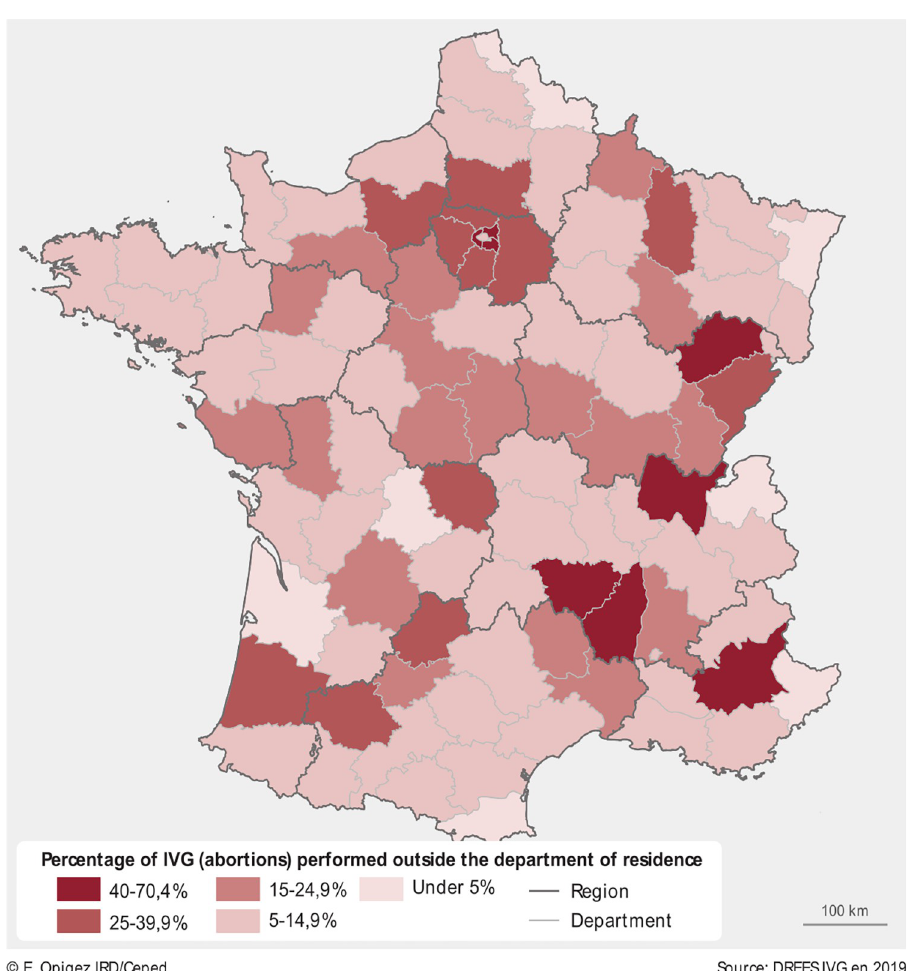
Fig 1. Percentage of abortions performed outside the department of residence, France, 2019. Source: [11]. Map produced by